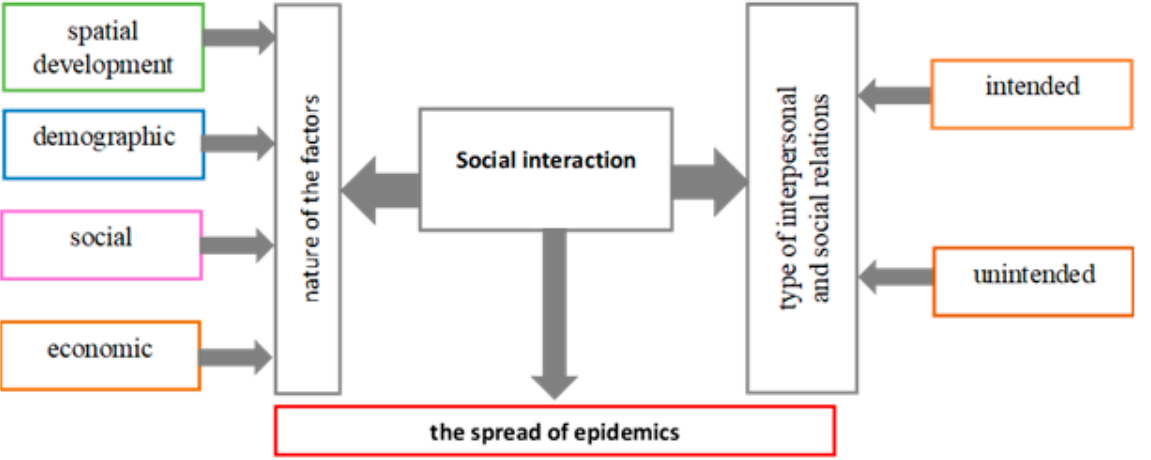
Figure 2. Research process pattern for determining the classification of areas with different levels of vulnerability to epidemic threats (KLE). Source: own elaboration. “Spatial development” refers to factors related to the management of space by humans (e.g., through buildings).